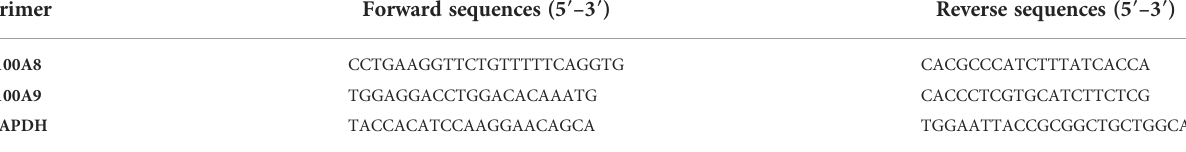
TABLE 2 Primer sequences used for quantitative real-time PCR (RT-PCR).